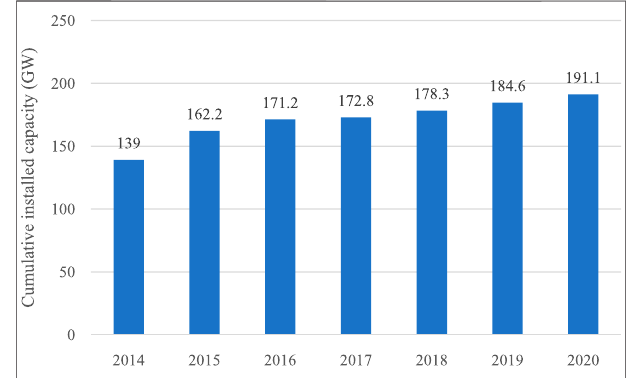
FIGURE 1 | Cumulative installed capacity of the globalenergystorage in 2014 – 2020 (source: CNESA).